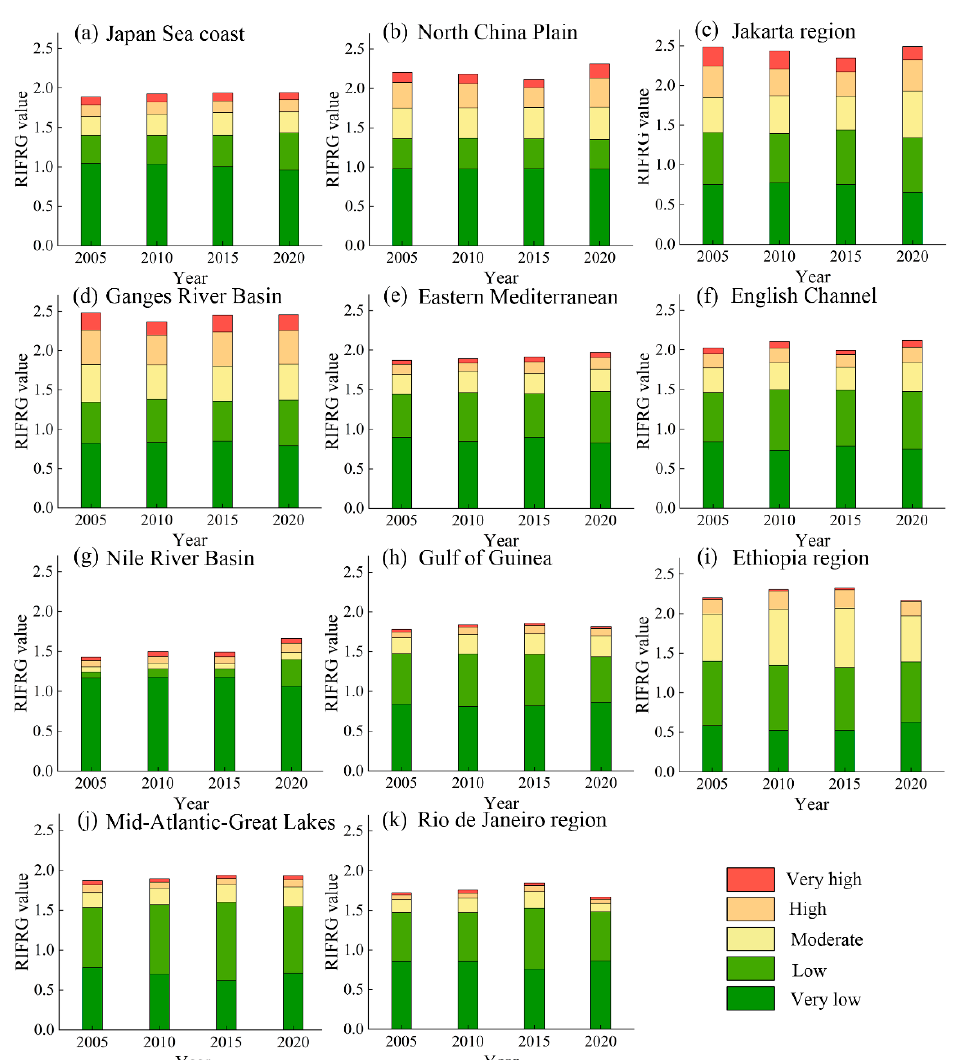
Figure 6. Temporal evolution of global flood risk hotspot regions.